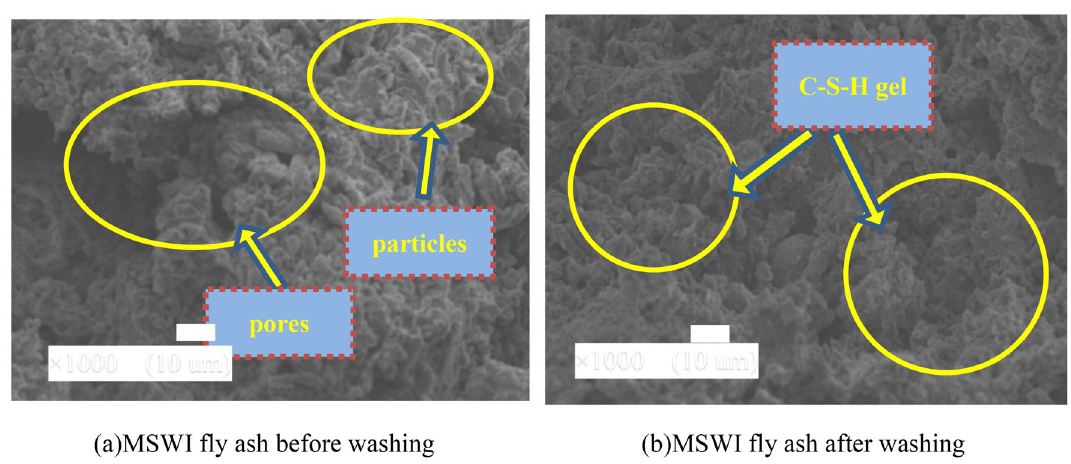
Figure 14. Influence of water washing treatment on micro-features of